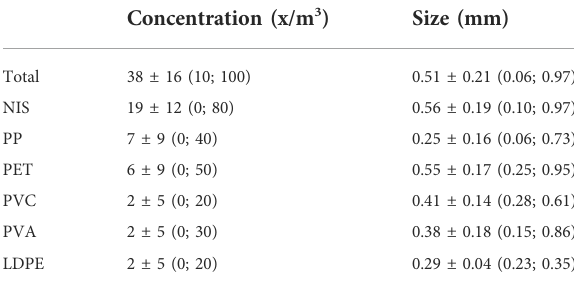
TABLE 3 Average microplastic concentrations (x/m 3 ) and average size (mm) in the Pantanal wetland surface